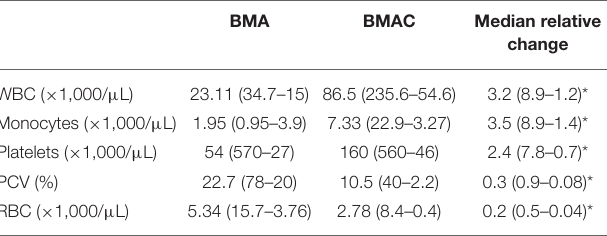
TABLE 3 | Cytology profiles of bone marrow aspirate (BMA) and its concentrate (BMAC).